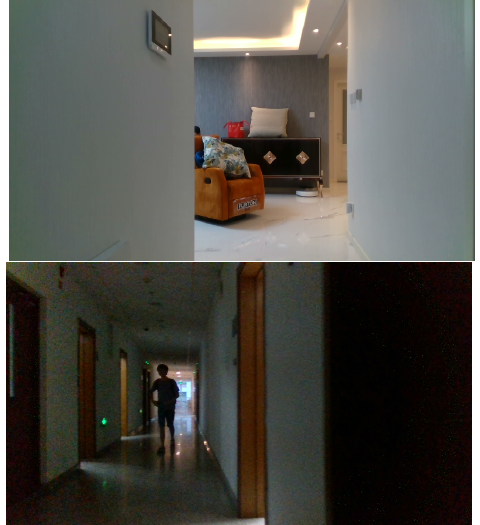
Figure 3. The structured indoor scenes from OpenLORIS-Scene dataset. (top) home1 scene. (bottom) corridor1 scene.